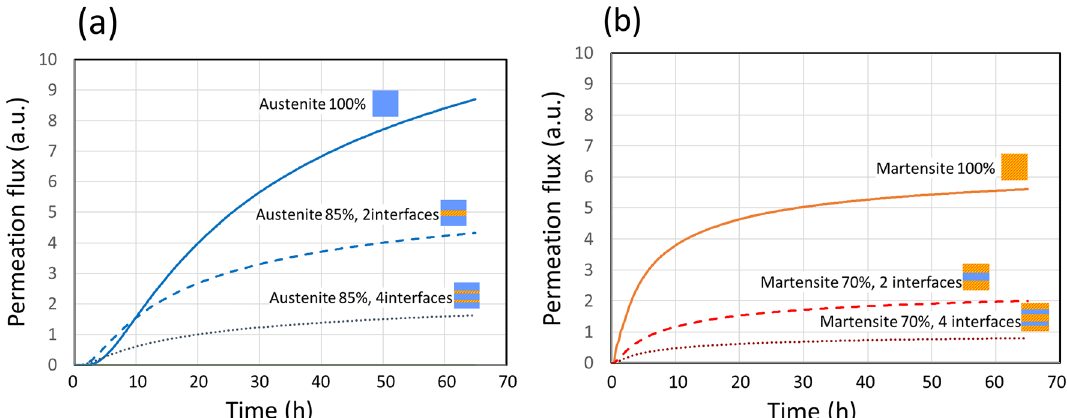
Figure 5. Simulated time evolution of the permeation flux of hydrogen through a 100-µm-thick sample with varied structure. ( a ) Hydrogen permeation through samples with austenite-dominant structure (85% austenite and 15% martensite) with two interfaces and four interfaces, and through pure austenite. ( b ) Hydrogen permeation through martensite-dominant structure (30% austenite and 70% martensite) with two interfaces and four interfaces, and through pure